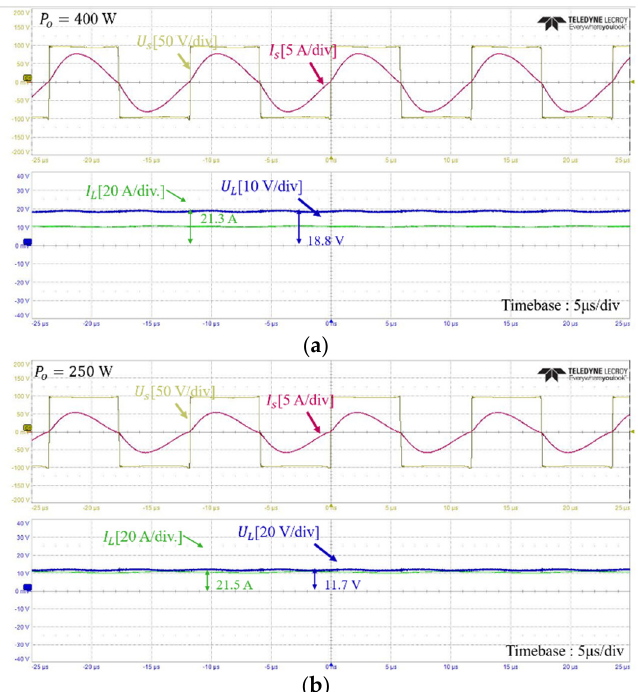
Figure 11. Experimental waveforms of the SS topology with the conventional design: ( a ) P o = 400 W; ( b ) P o = 250 W.